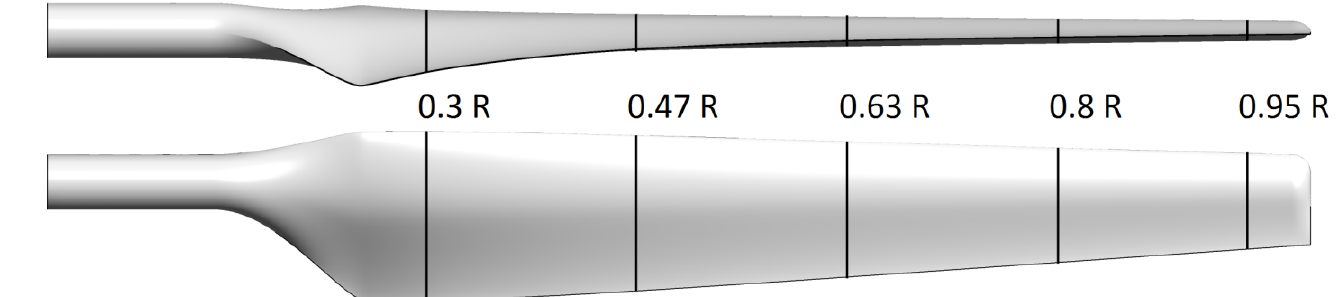
Figure 3. Rotor blade geometrical model with the five pressure measurement sections.